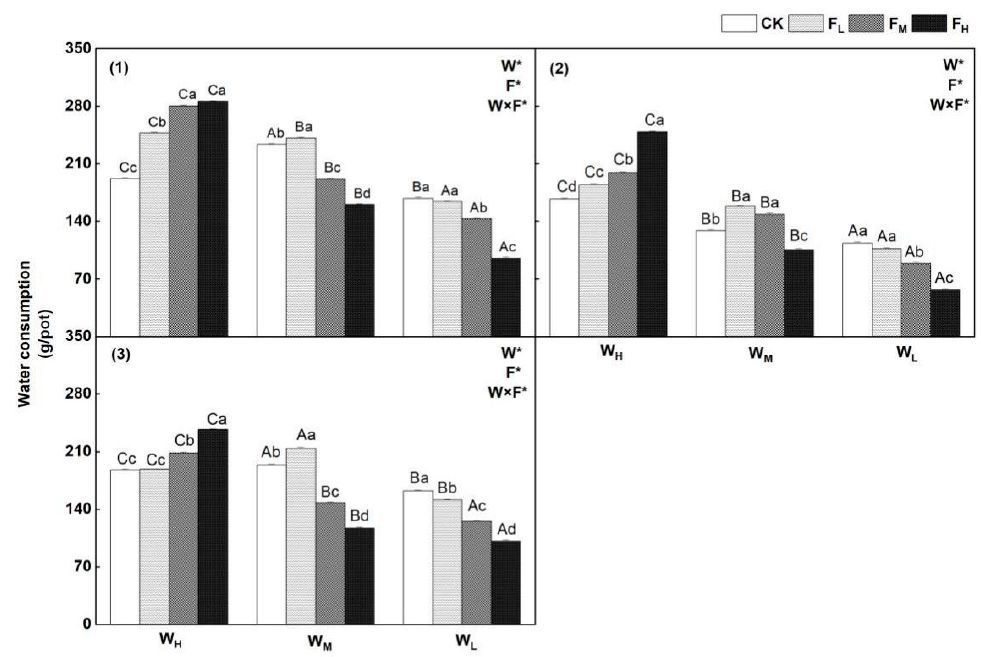
Figure 8. Changes in water consumption values of test plant species under different water–fertilizer treatments. Numbers ( 1 ) − ( 3 ) in brackets indicate P. crymophila , F. coelestis , and S. purpurea , respectively. W, F, and W × F indicate the results of ANOVAs ( p < 0.05) for the effects of water, fertilizer, and their interactions. Asterisk (*) and ns indicate significant difference and non-significant. The uppercase letters and lowercase letters represent the difference between water and fertilizer treatments.